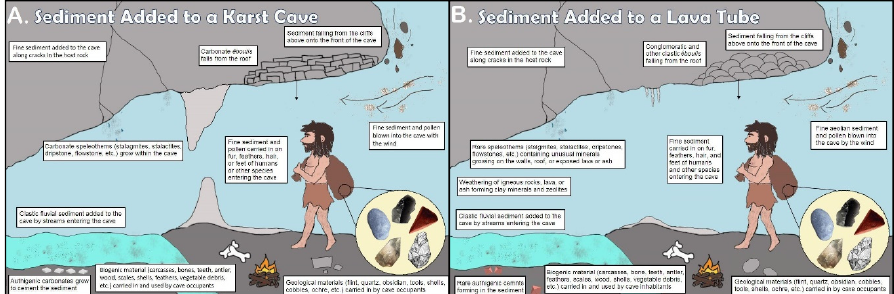
Figure 2. Sediment sources for caverns. Groundwater or surface water as fluvial or seeping in along cracks can transport sediment into caverns. Winds may add aeolian clastic or volcaniclastic sediment. Humans may contribute manuported minerals or fossils used as tools and ritual objects, but their fires also can add ash, burnt or charred wood and bone. Animals, including humans, accumulate their excretia, food debris, and their degradation products. As well as the dust and silt trapped on their feet, and in their pelts, feathers, or clothing, animals contribute their hunted or foraged prey carcasses. Plants add pollen. From the cave walls, roof, and the cli ff face above the mouth come physical, chemical and biological weathering that contribute mass wasting products, including é boulis , as the cave stopes upward. Diagenetic processes and cementation can also add new authigenic minerals: ( A ) In karst systems, carbonate deposits, like stalagmites, stalactites, flowstone, and tufa, as well as authigenic carbonate cements usually form a significant sedimentary component. ( B ) In a grotto within a lava tube, carbonate sediment and cements will likely be insignificant compared to the clay generated by degradation of the igneous minerals or volcanic